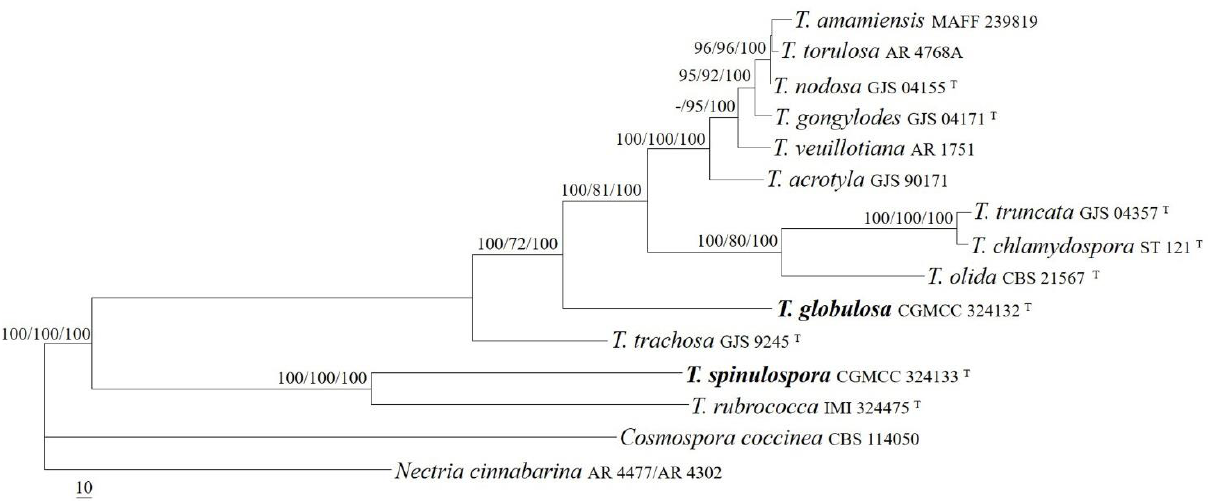
Figure 3. The maximum likelihood tree inferred from combined act, ITS, LSU, rpb1, and tub2 sequences of representative species of Thelonectria . MLBP ( left ) and MPBP ( middle ) values greater than 70% and BIPP ( right ) values greater than 90% were shown at the nodes.